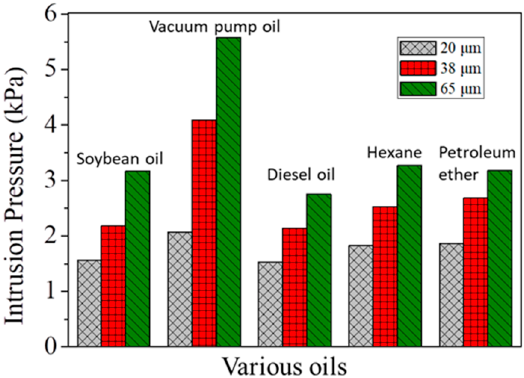
ff erent thicknesses for various